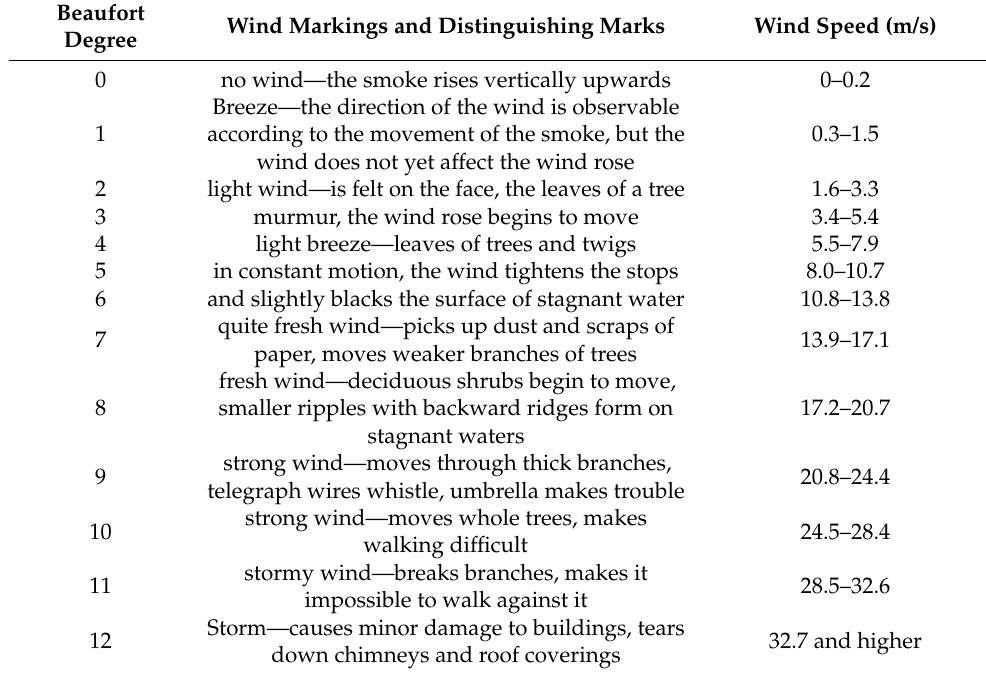
Table 1. Beaufort wind scale.